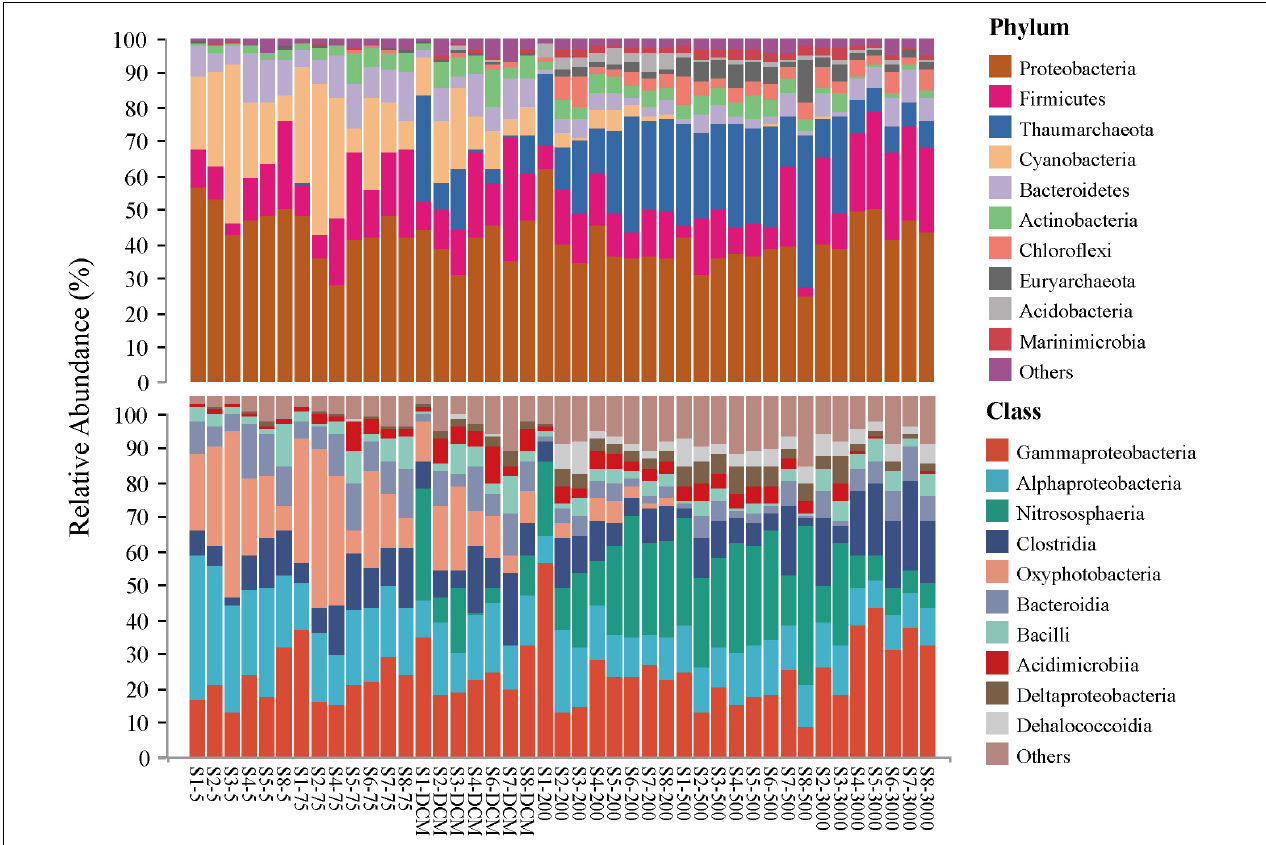
FIGURE 2 | Relative abundance of microbial taxonomic groups at the phylum (top 10 phyla and others) and the class (top 10 classes and others) level across 43